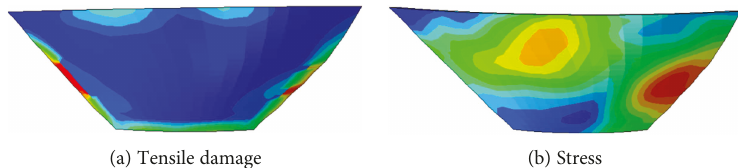
Figure 19: Dynamic response distribution of arch dam at t = 5 425 s .